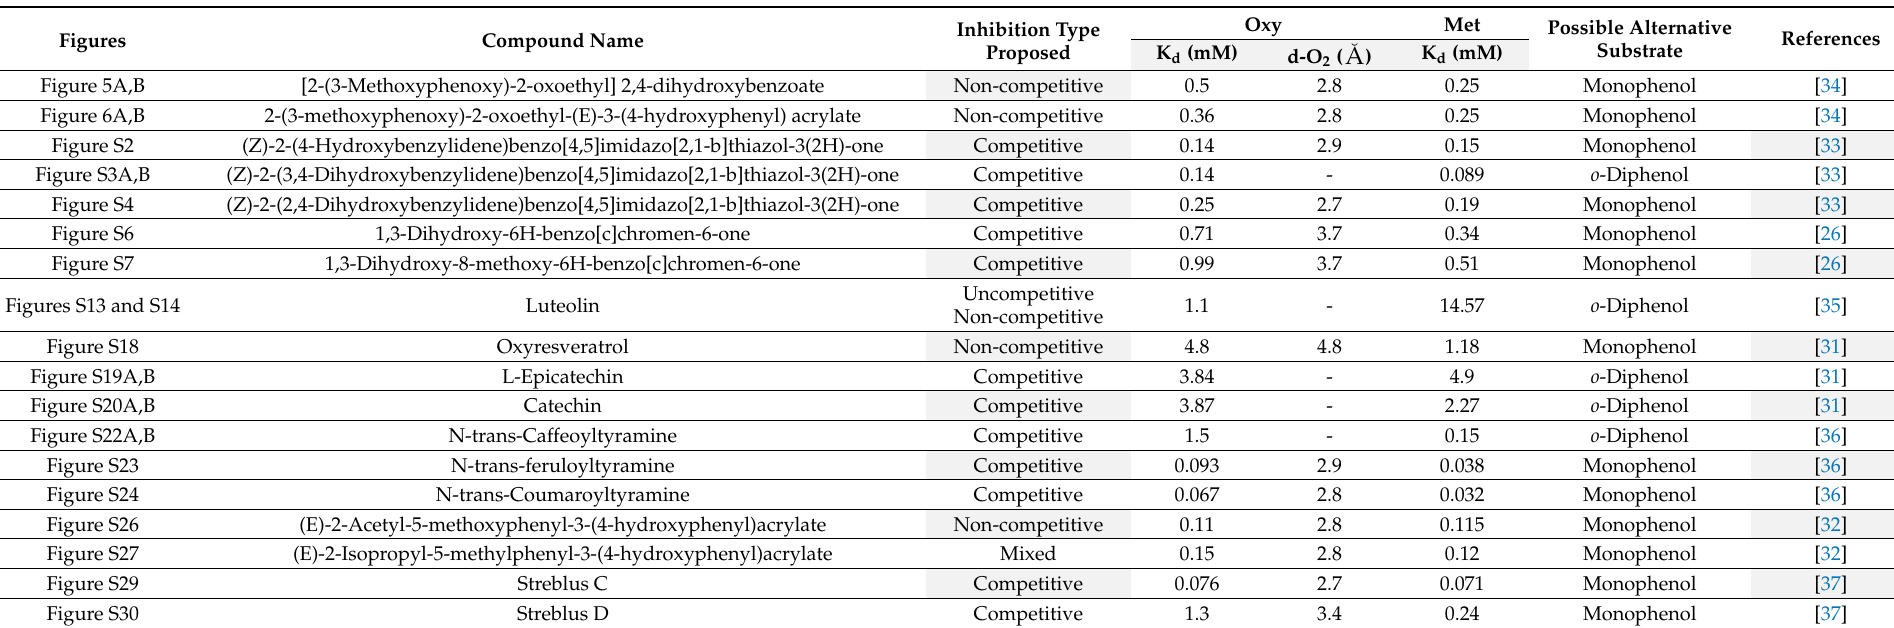
Table 3. Compounds described as inhibitors: competitive, non-competitive, uncompetitive and mixed, which can behave as alternative substrates or as suicide substrates. K d is the ligand dissociation constant of docking to the active site of oxy and met -tyrosinase. d-O 2 corresponds to the distance from the oxygen atoms of the peroxide group of oxy -tyrosinase to a carbon atom adjacent to a -OH group. Oxy Met Possible Alternative ReferencesFigures Compound Name Inhibition Type Substrate Proposed